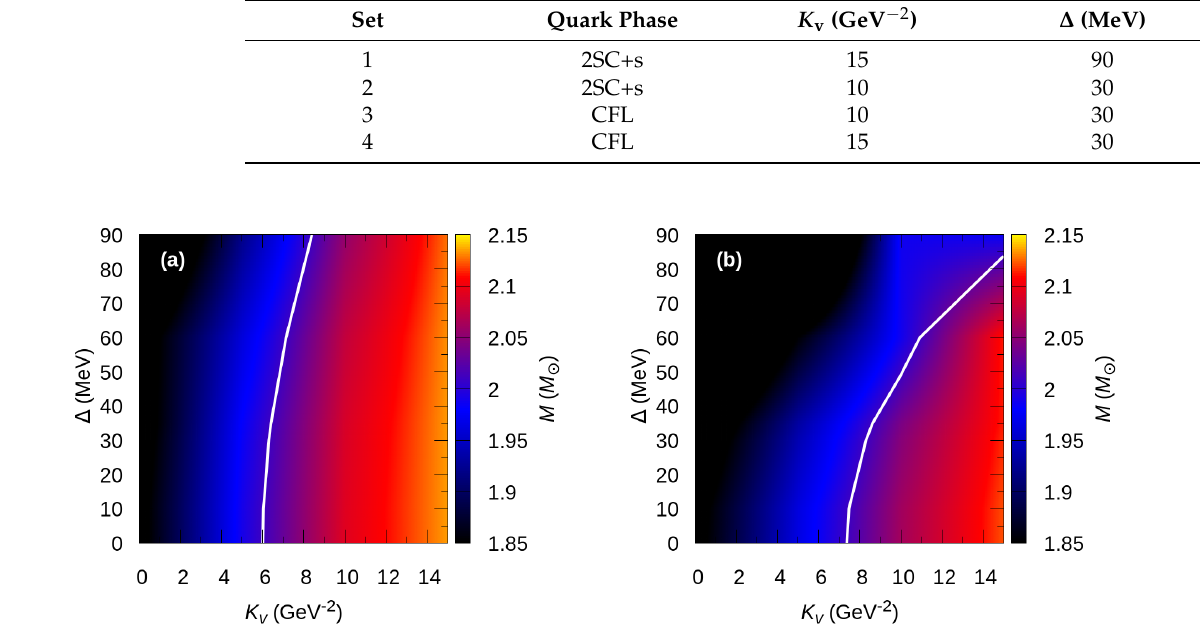
Figure 5. (Text) Maximum mass of stars as a function of ∆ and K v , for the 2SC+s quark matter (panel ( a )) and CFL quark matter (panel ( b )). The white curve marks the maximum mass constraint M max = 2.01 M (cid:12)